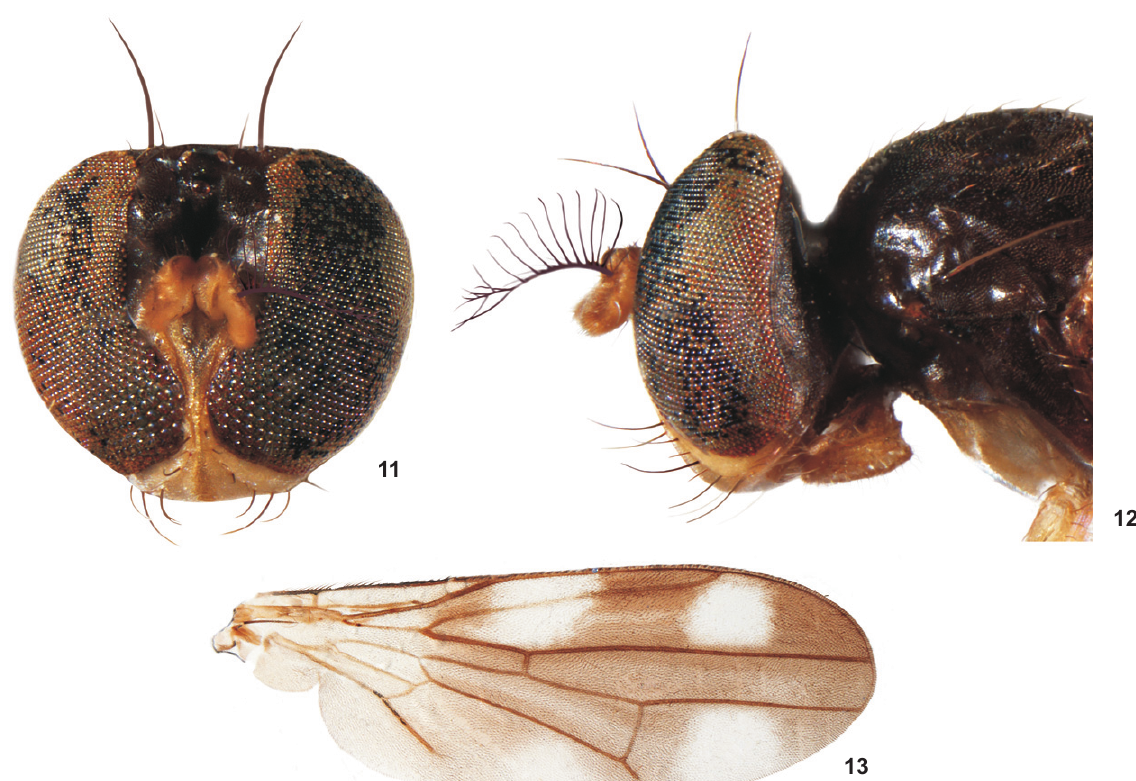
Figures 11-13. Photographs of Cyamops manauensis sp. nov. , male paratype: (11) head, frontal view; (12) head and anterior portion of thorax, lateral view; (13) wing, dorsal view. Not all to the same